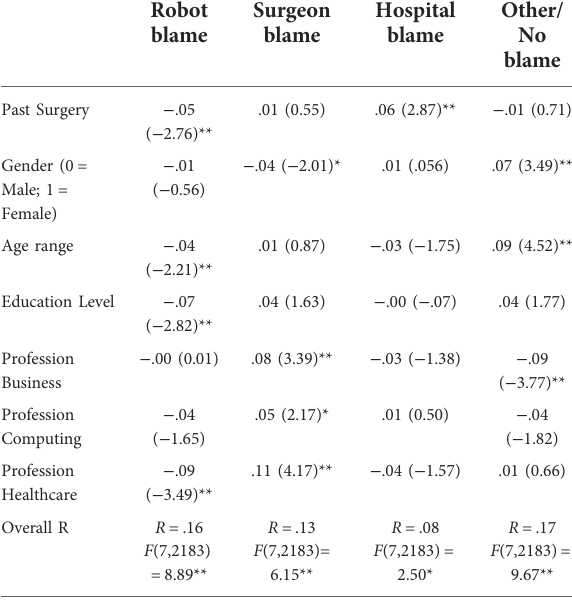
TABLE 3 Linear regression predicting blame across